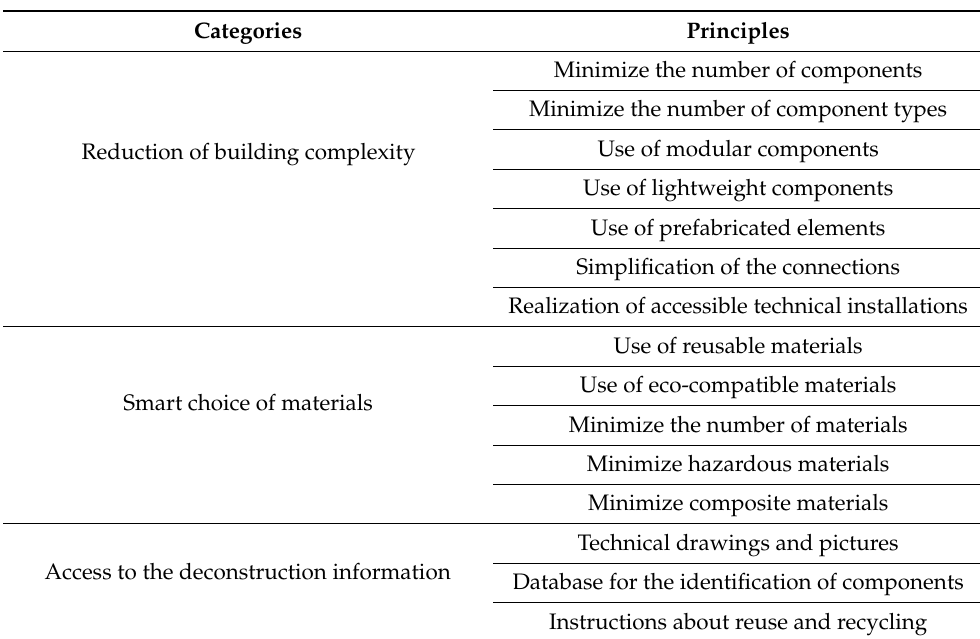
Table 6. Deconstruction